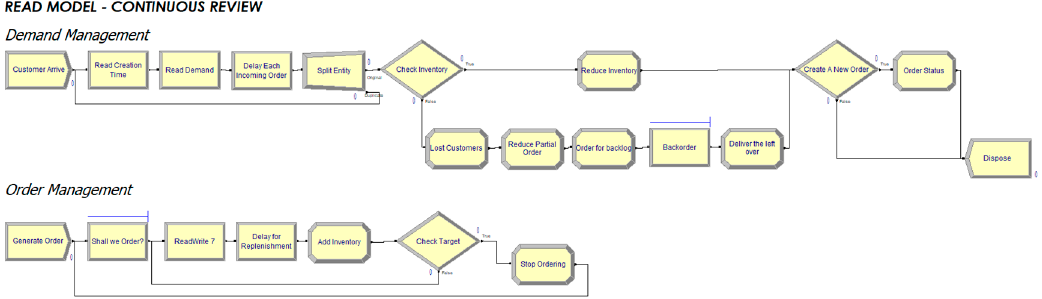
Figure 6. Read model of continuous review policy.